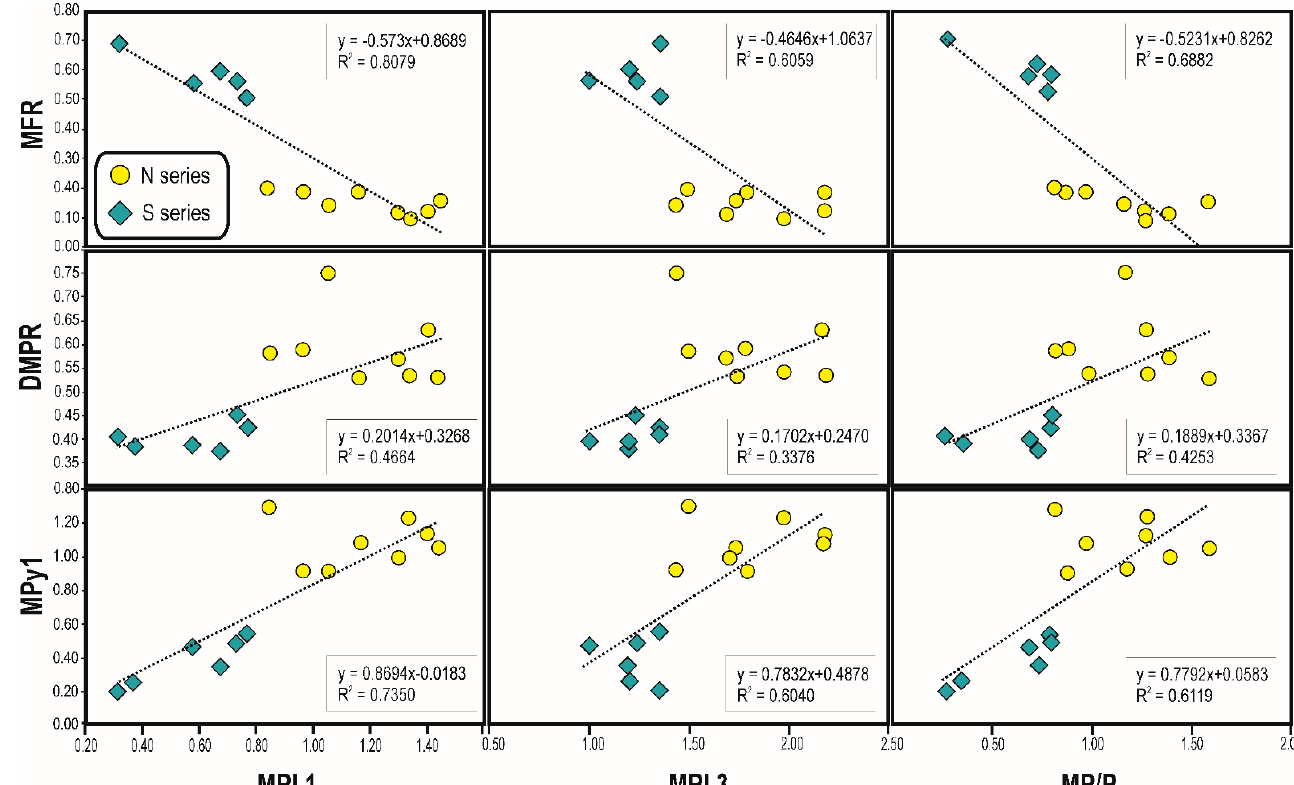
Figure 17. Correlations of PAHs diagnostic ratios.